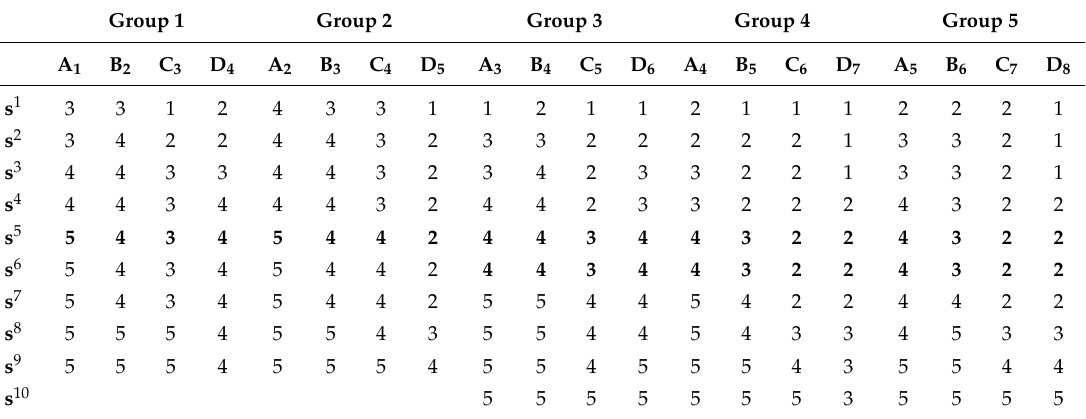
Table 5. Scores assigned by the panelists on each day. The medians are shown in